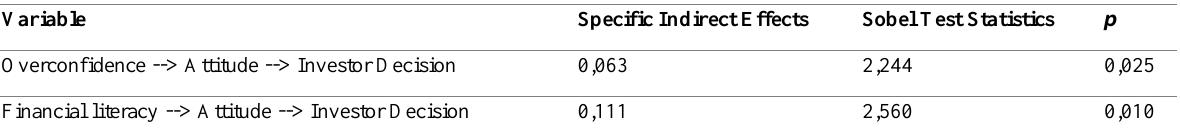
Table 5: Specific Indirect